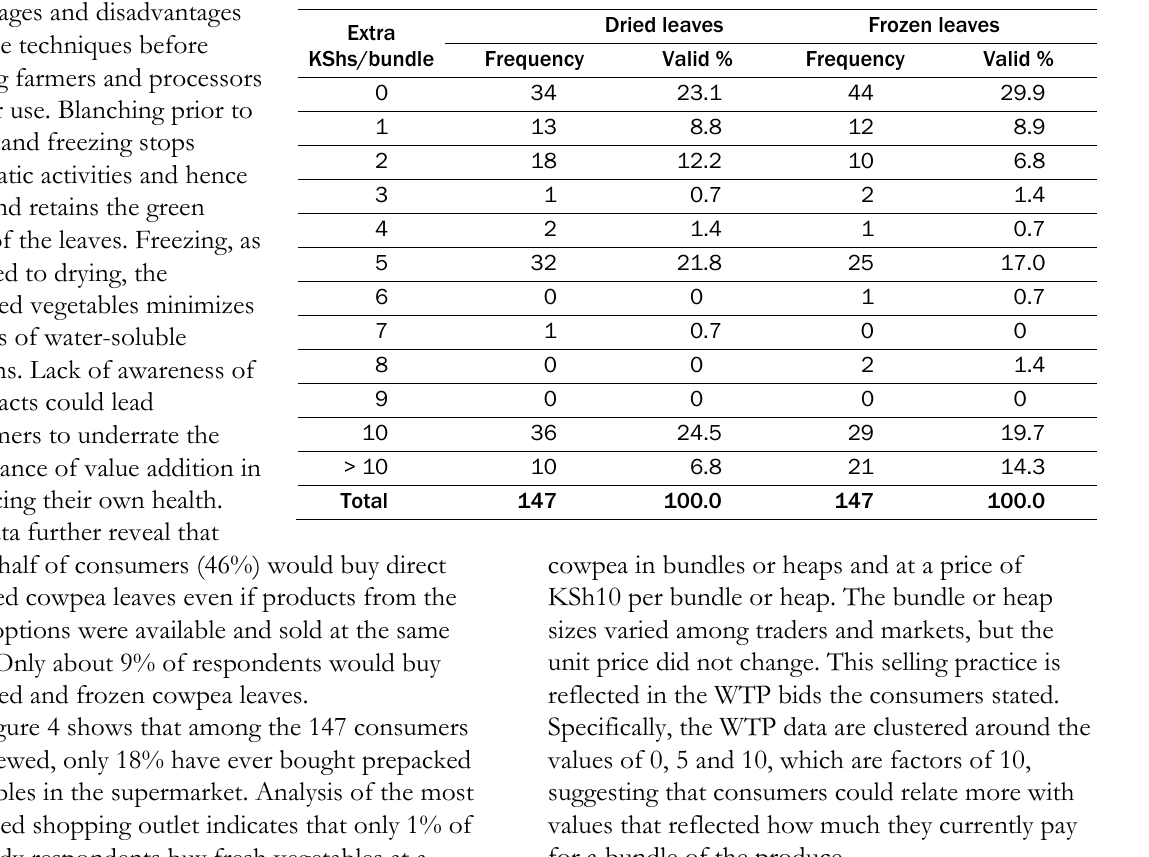
Table 5. Distribution of Consumers’ Willingness To Pay for Dried and Frozen Dried Cowpea Leaves ( N